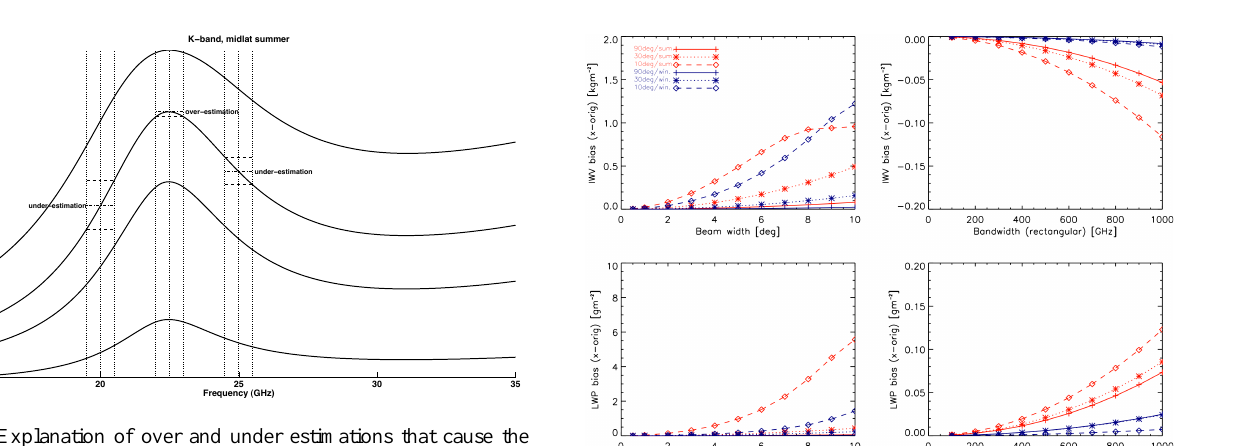
Fig. 5. Explanation of over and under estimations that cause the Figure 5. Explanation of over and under estimations that cause the bandwidth errors, which 5 bandwidth errors, which are linked to the curvature of the TB are linked to the curvature of the TB vs frequency curve in K-band for the mid-latitude 6 vs. frequency curve in K-band for the mid-latitude summer sound- ing. The vertical dotted lines represent the 1GHz bandwidth (centre summer sounding. The vertical dotted lines represent the 1GHz bandwidth (center line is 7 line is centre frequency). The short horizontal dashed lines are used center frequency). The short horizontal dashed lines are used to locate the intersection of the 8 to locate the intersection of the extremities of the bandwidth and extremities of the bandwidth and the dashed dot line locates the center frequency on the TB 9 the dashed dot line locates the centre frequency on the TB curve. curve. These additional lines help to visually see that the over-estimation and under-10 These additional lines help to visually see that the over-estimation estimation errors are linked to the curvature of the TB curve. 11 and under-estimation errors are linked to the curvature of the TB curve.